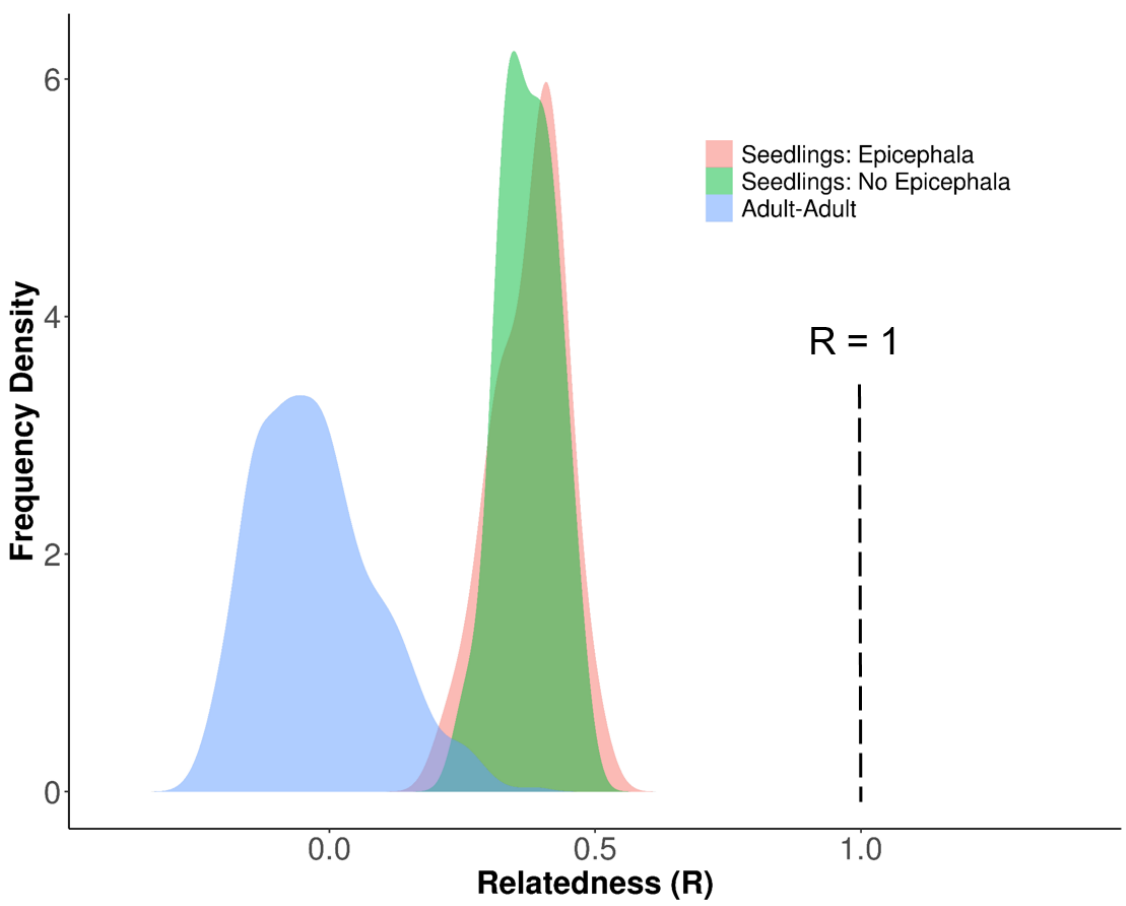
Figure 4. Frequency density function of pairwise relatedness coefficients (r) between B. oblongifolia mother and seedlings from fruits that contained Epicephala (N = 20), didn’t contain Epicephala (N = 31) and between randomly chosen adults in the popula- tion (Adult, N = 43). The dashed line denotes the expected values of r under apomictic